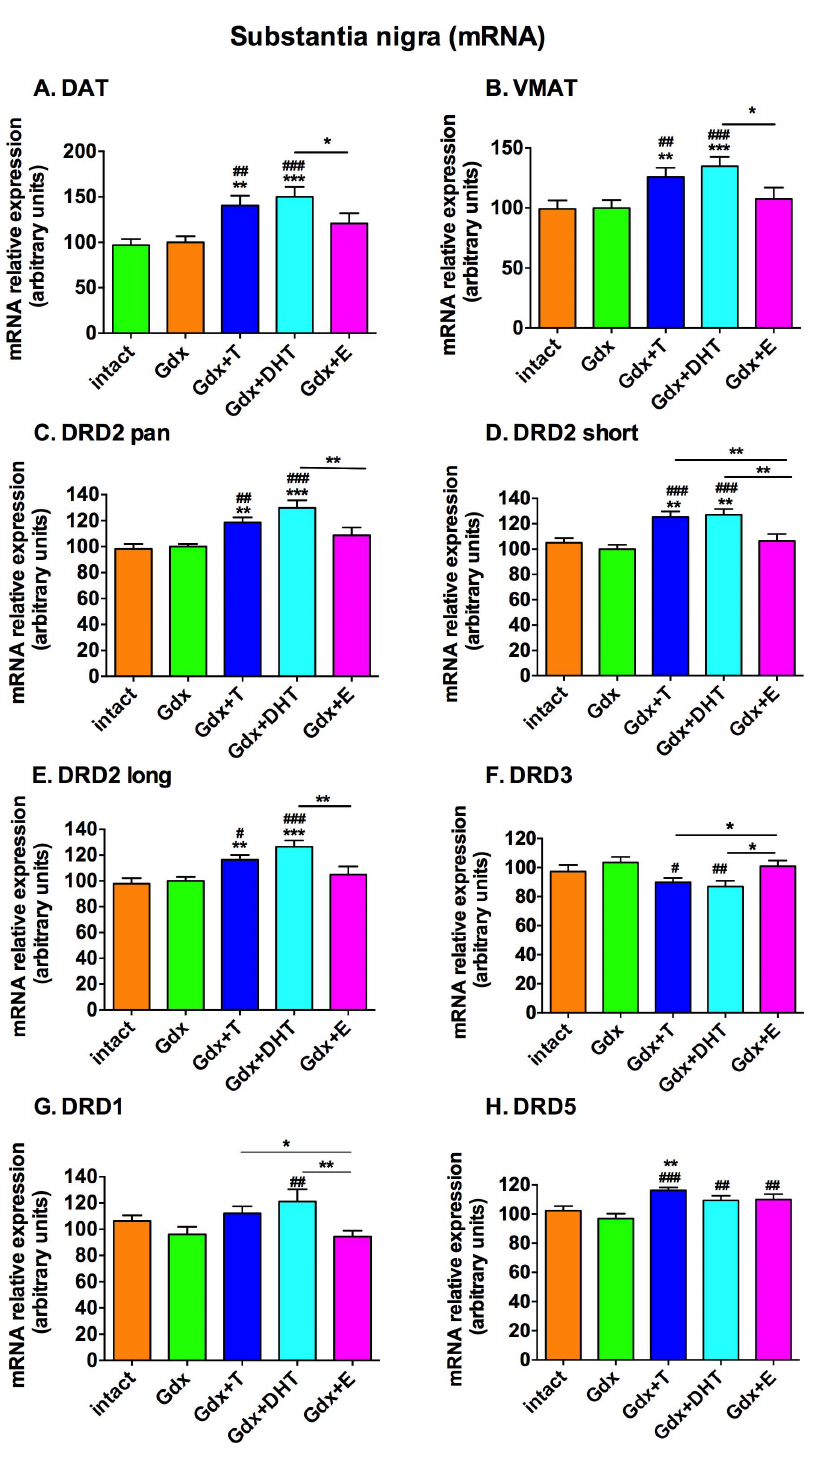
Figure 1. Effect of gonadectomy and sex steroid replacement on presynaptic dopamine transporter and dopamine receptor mRNA expression in the substantia nigra of adolescent male rats. DAT (A) and VMAT (B) mRNA expression were increased by androgens but not by 17 b -estradiol replacement. (C) DRD2 pan, (D) DRD2 short and (E) DRD2 long mRNAs were increased by testosterone and DHT replacement relative to Intact and Gdx groups. 17 b -estradiol replacement had no effect on DRD2pan, D2S or D2L mRNA levels. (F) DRD3 mRNA was decreased by testosterone and DHT replacement relative to Gdx. 17 b -estradiol replacement had no effect on DRD3 mRNA. (G) DRD1 mRNA was increased by DHT replacement relative to Gdx. Testosterone and 17 b - estradiol replacement had no effect on DRD1 mRNA expression. (H) DRD5 mRNA was increased by testosterone replacement relative to Intact and Gdx groups and increased by DHT and 17 b -estradiol replacement relative to the Gdx group. * denotes comparison with Intact, unless comparison is indicated by a line, # denotes comparison with the Gdx group, * and # p , 0.05, ** and ## p , 0.01, *** and ### p , 0.001, n=12–15/group.